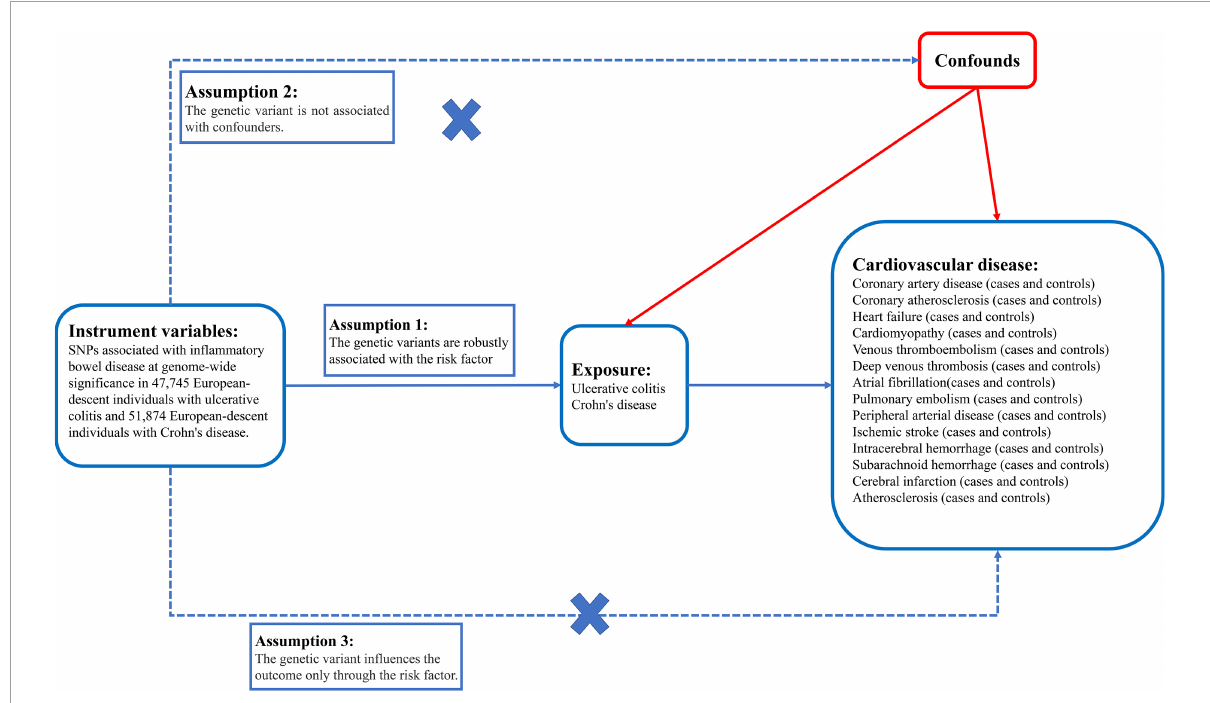
FIGURE2 There are three core instrumental variable assumptions for Mendelian randomization